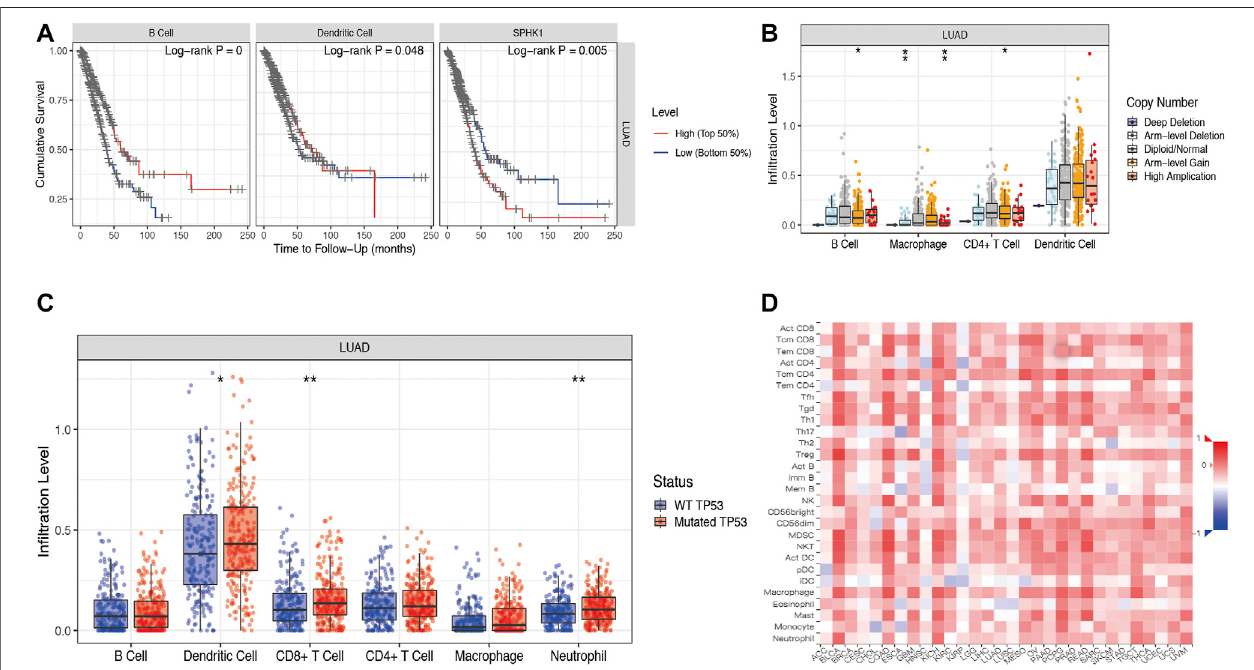
FIGURE 13 | Associations among OS, SCNA of SPHK1, and TIL levels. (A) Cumulative survival rates between low and high immune cell (B cell and dendritic cell) in fi ltration;Kaplan – Meier survivalanalysisbydifferentSPHK1 expression levels ofLUAD. (B) Correlationbetween SCNA levelofSPHK1 and immune cellin fi ltration level. (C) TP53 mutation rates were associated with CD8 + T cell, neutrophil, and dendritic cell in fi ltration levels. (D) Heat map analysis of SPHK1 expression level and tumor- in fi ltrating lymphocytes. OS, overall survival; SCNA, somatic copy number variation; TILs, tumor-in fi ltrating lymphocytes; LUAD, lung adenocarcinoma.